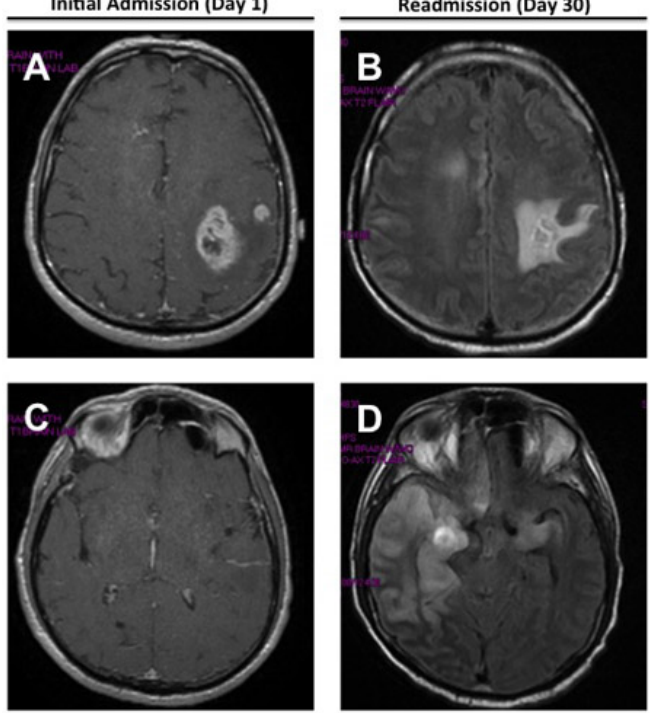
Figure 1. Axial MR images of brain with contrast demonstrating T1 weighted left temporoparietal enhancing lesions on initial presentation ( A , C ), and T2 FLAIR right frontotemporal signal abnormalities on hospital readmission ( B , D